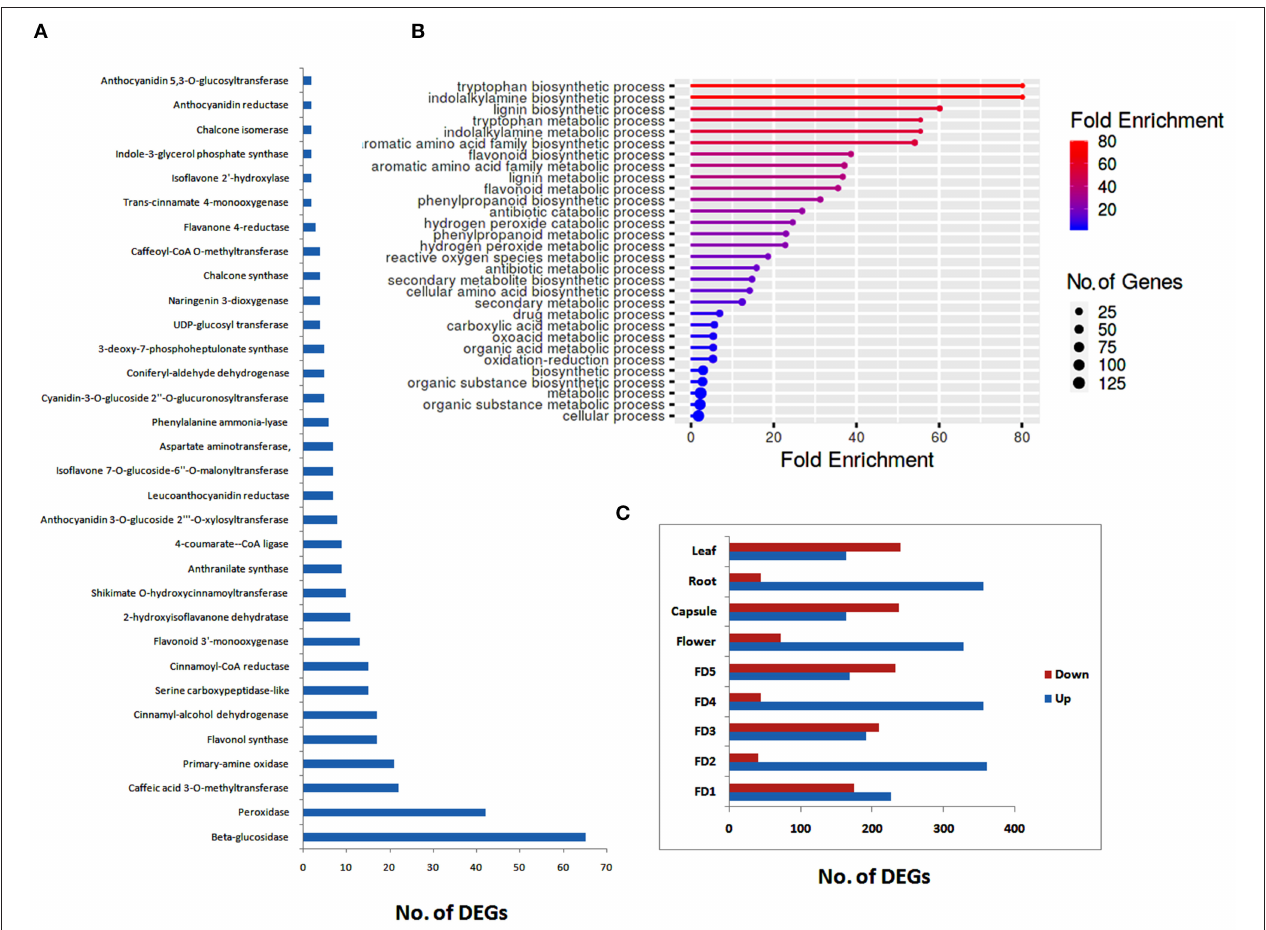
FIGURE 1 | Distribution of secondary metabolite data into enzyme classes (A) , major biological process enrichments (B) and up- and downregulated differentially expressed genes (DEGs) for different tissues (C)